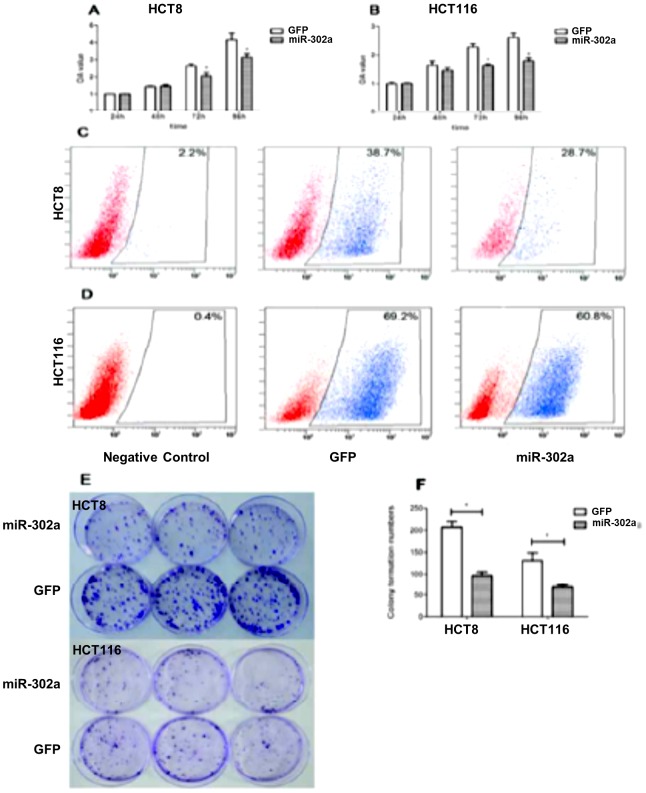
Overexpression of miRNA-302a significantly inhibits cell proliferation in colon cancer cells in vitro.CCK-8 assay was performed to measure proliferation in (A) HCT8 and (B) HCT116 cells. Data represent the mean ± standard deviation of the optical density (OD) value detected at 450 nm from three independent experiments. Cell proliferation was detected in (C) HCT8 and (D) HCT116 cells using EdU assay analyzed by flow cytometry. (E, F) Colony formation assays indicated fewer colonies in miRNA-302a overexpressing HCT8 cells. (*P<0.05).